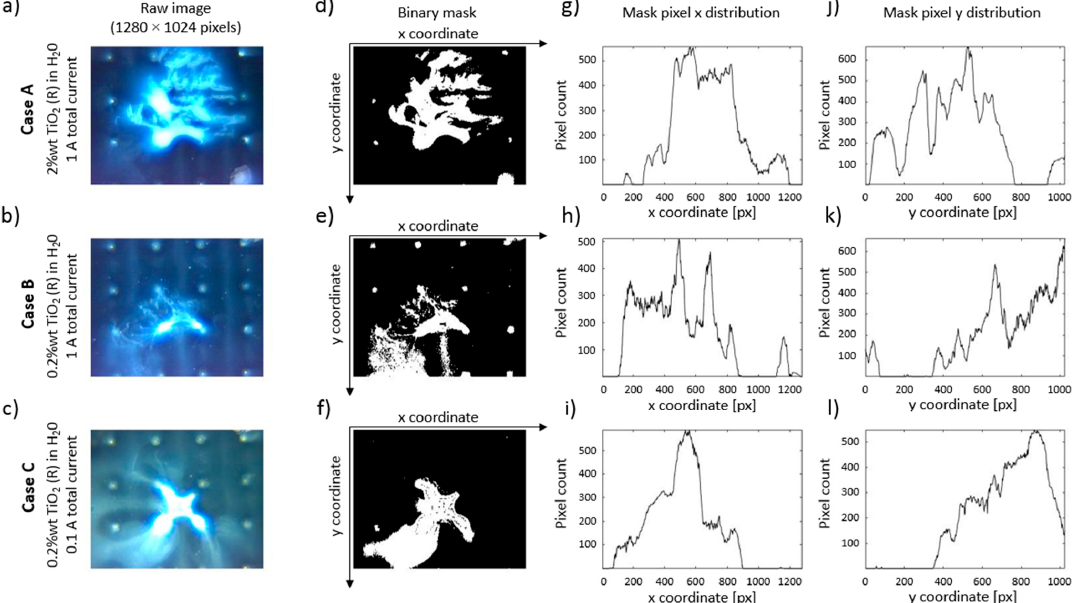
Figure 13. Example image post-processing results for the beginning of middle defocusing experiments. ( a – c ) Raw image data A, B, and C cases (panels a, b, and c, respectively); ( d – f ) computed binary masks for raw image data a-c, respectively; ( g – i ) binary mask pixel distribution (summed along image y-axis); ( j – l ) binary mask pixel distribution (summed along image x-axis).